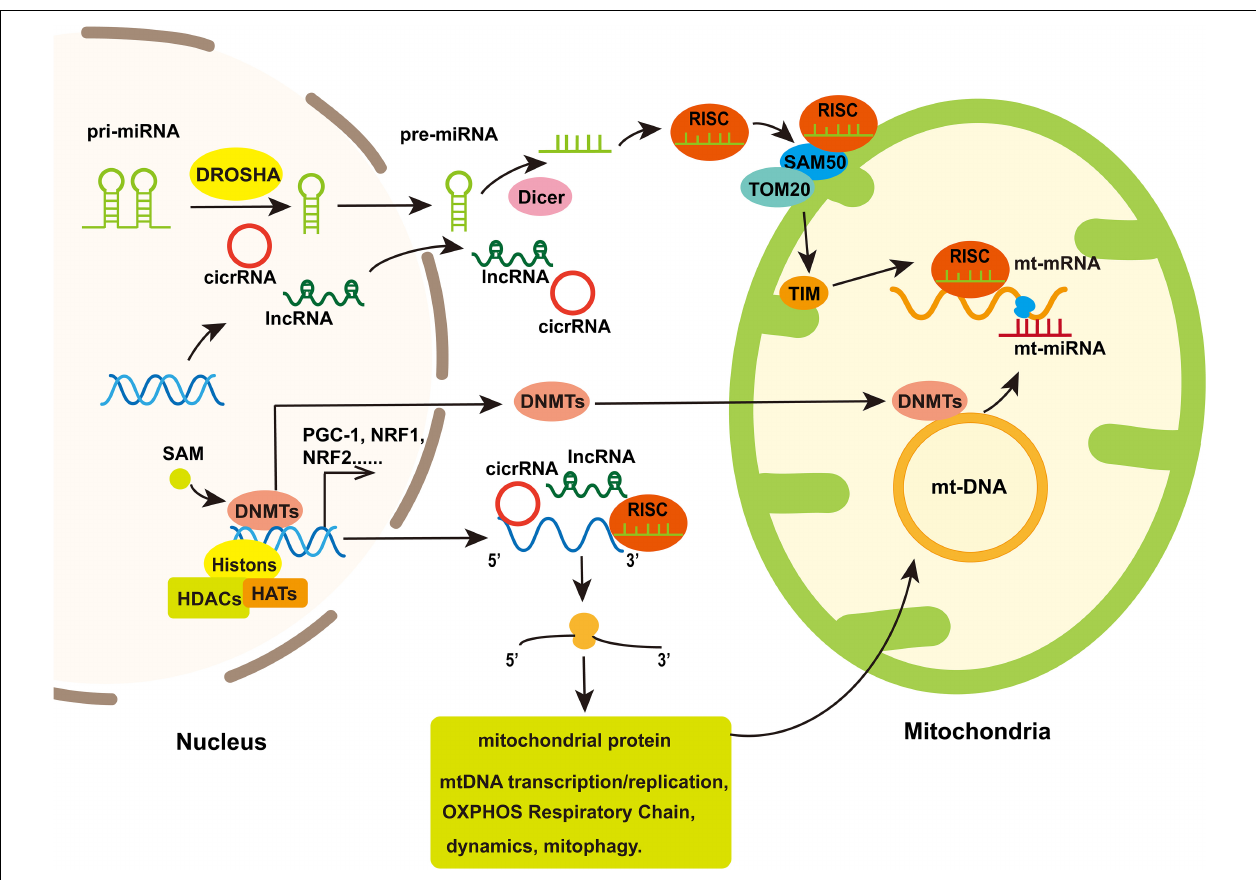
FIGURE 3 | The involvement of mitochondria in nuclear epigenetic regulation and mtDNA methylation. Mitochondrial genomes can be modified by methyltransferases which are transport from nuclear to mitochondria. Simultaneously, Histone acetylation/deacetylation and DNA methylation participate in the expression of nuclear-encoded genes regulated mitochondrial function including some transcription factor that regulated genes associated with mitochondrial biogenesis. Non-coding RNA, including miRNA, lncRNA, and cicrRNA, coded by nucleus genome or several miRNAs coded by mt-DNA, can regulate genes encoding part of proteins in mitochondria to influence mitochondria biogenesis, mitochondrial dynamics, mitophagy, and cell apoptosis. In addition, the nuclear-encoded miRNAs assemble with Ago to form the RNA-induced silencing complex (RISC), which is improved into the mitochondria through protein channels in mitochondria membrane and thereby regulate mt-mRNA